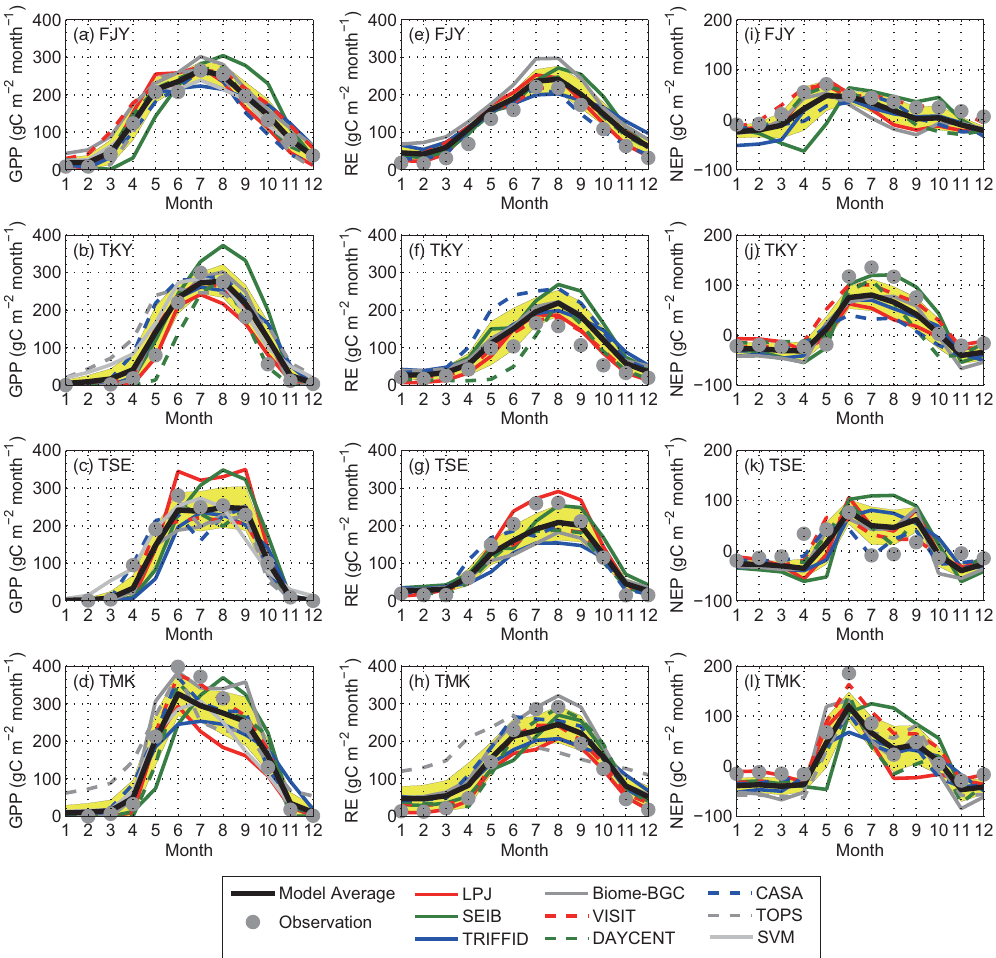
Fig. 4. Same as Fig. 2 but for modified